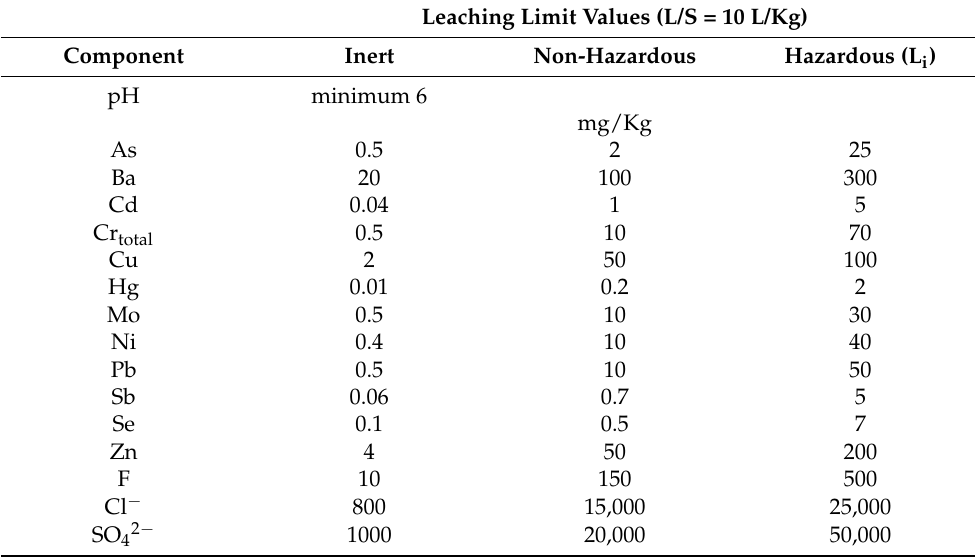
Table 1. Leaching limit values established by Council Decision 2003/33/EC